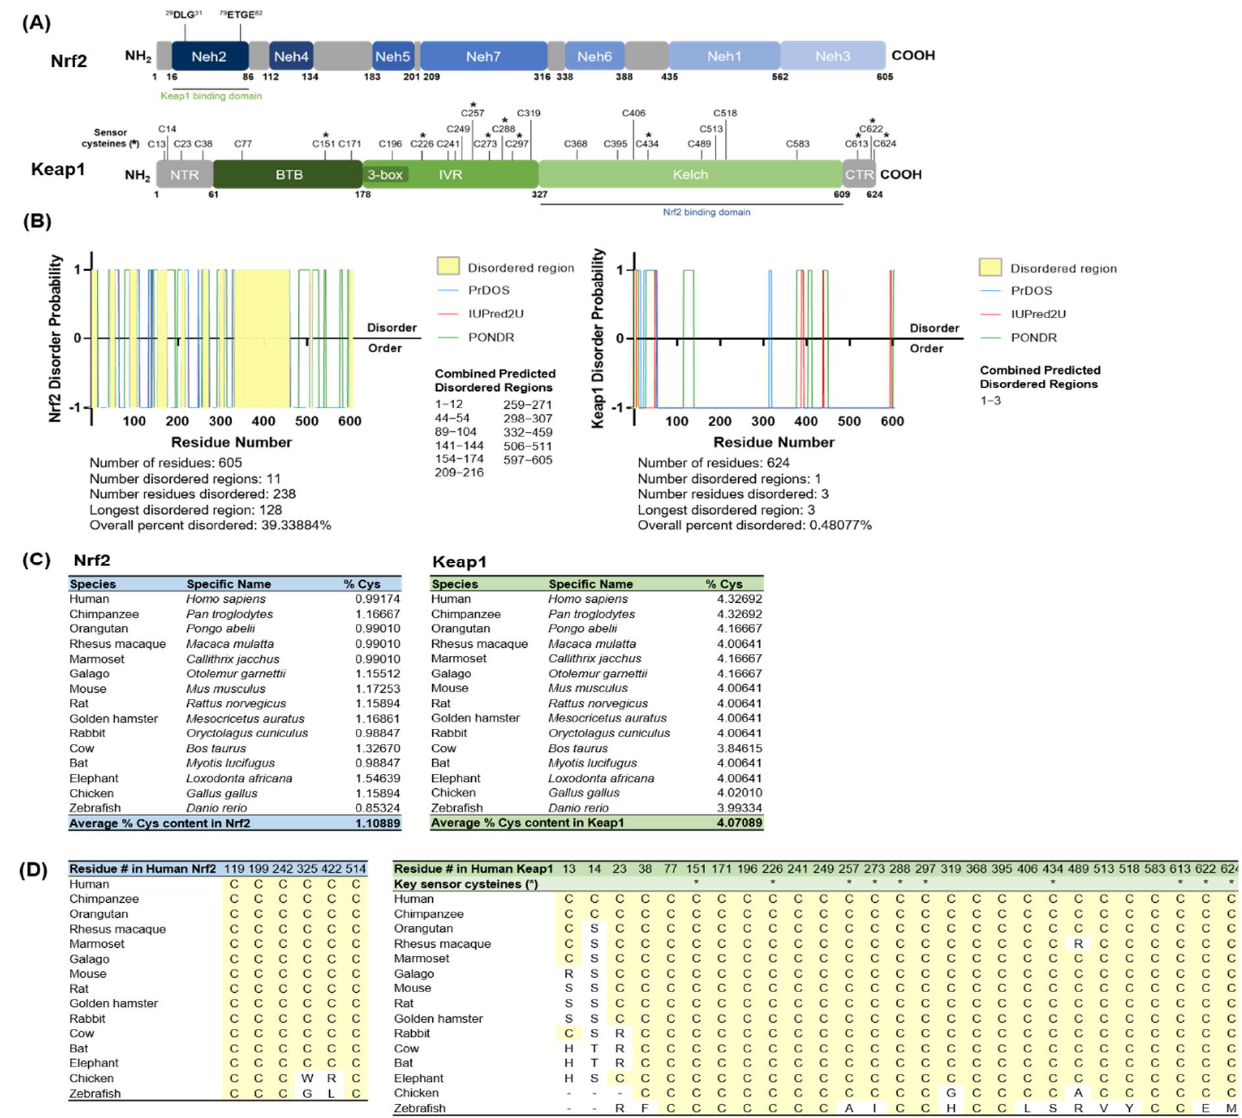
Figure 1. Protein disorder analyses and cysteine analyses for Nrf2 and Keap1. ( A ) Domain maps for Nrf2 and Keap1 show the location of all cysteine residues. Key oxidative stress-sensing cysteines in Keap1 are marked with an asterisk (*). ( B ) Disordered profile plots for Nrf2 and Keap1 predicting the location of intrinsically disordered regions within each protein as predicted by three independent algorithms (PrDOS, IUPred2A, and PONDR). The intrinsically disordered regions predicted by all three algorithms are highlighted in yellow. ( C ) The percentage of cysteine content is calculated for 15 species from human to zebrafish. ( D ) Protein sequence alignment for cysteine residues in Nrf2 and Keap1 across 15 species. All cysteines are highlighted in yellow. Sensor cysteines within Keap1 are marked with an asterisk (*).